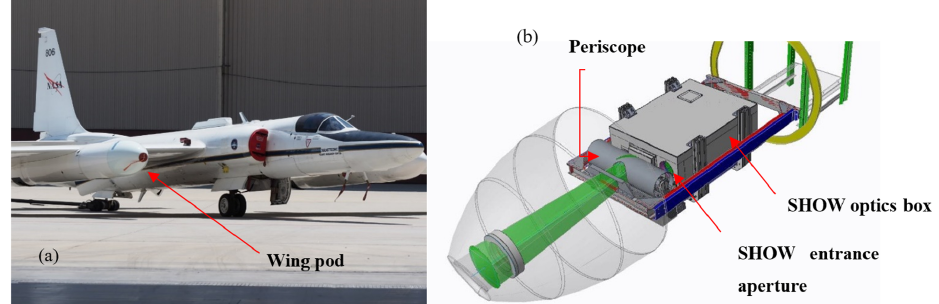
Figure 1. The NASA ER-2 airplane (a) and a schematic of the SHOW instrument depicted inside the ER-2 wing pod (b) .